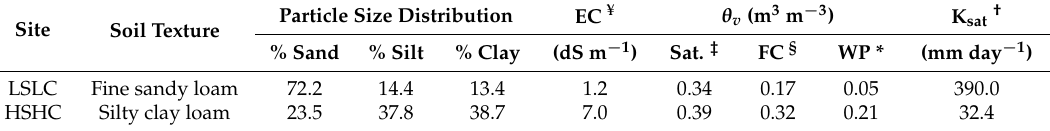
Figure 1. Experimental study site locations. Table 1. Soil properties at study sites.